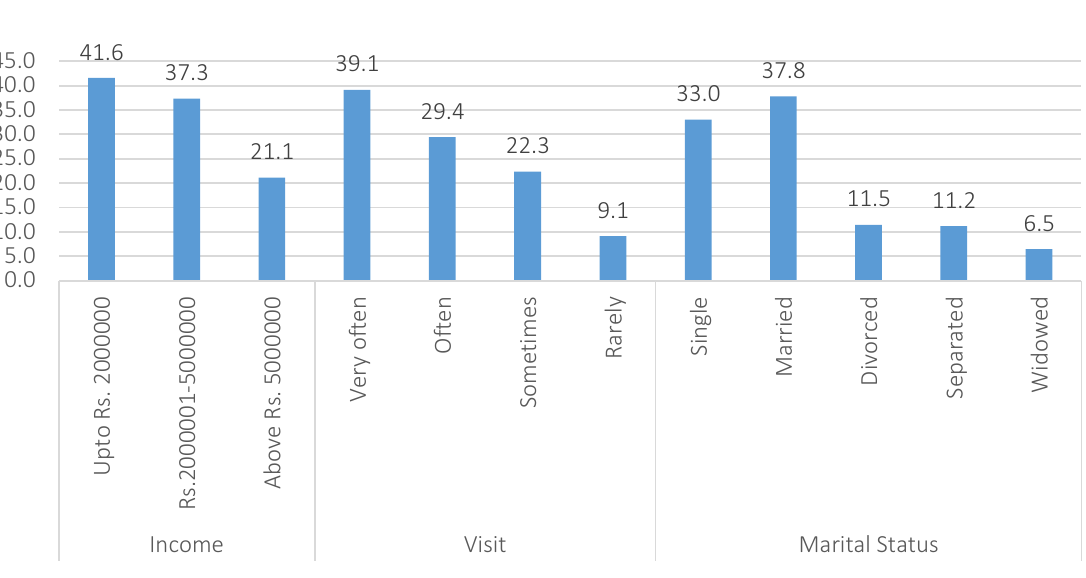
Figure 2. Demographic analysis based on income, visit, and marital